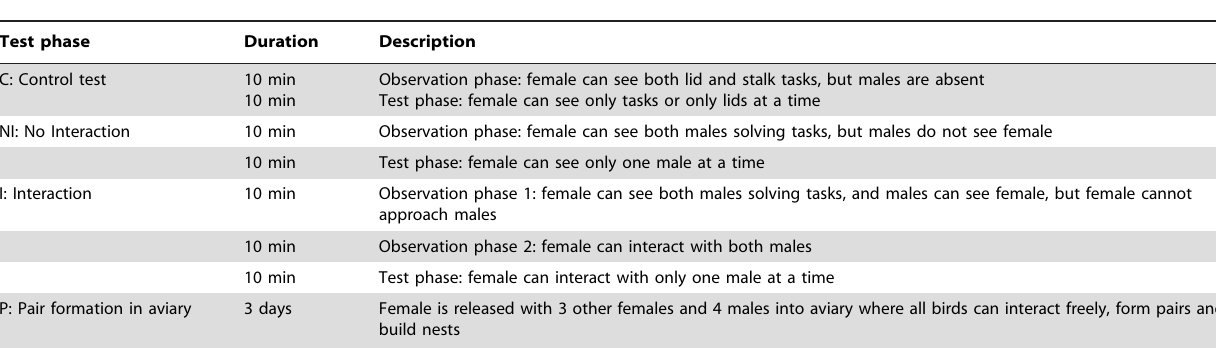
Table 1. Description of the different test phases.